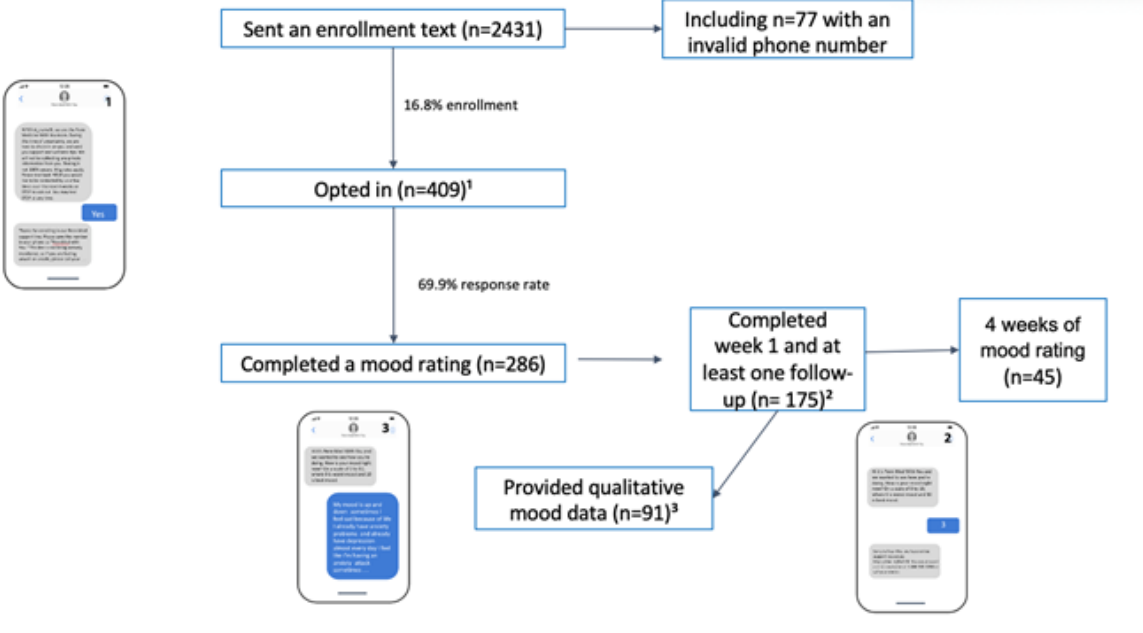
Figure 1. Schematic representation of the study design. A total of 2431 individuals were sent an enrollment text after being discharged from the emergency department at one of two academic medical centers emergency. Of them, 409 (17%) individuals opted in and were asked to self-report well-being, of whom 286 (70%) responded. Of them, 236 (83%) individuals provided a mood rating at week 1 and 175 (60%) responded during week 1 and at least one follow-up, including 101 (35%) individuals who responded at weeks 1 and 4. Furthermore, 45 (16%) participants responded at all 4